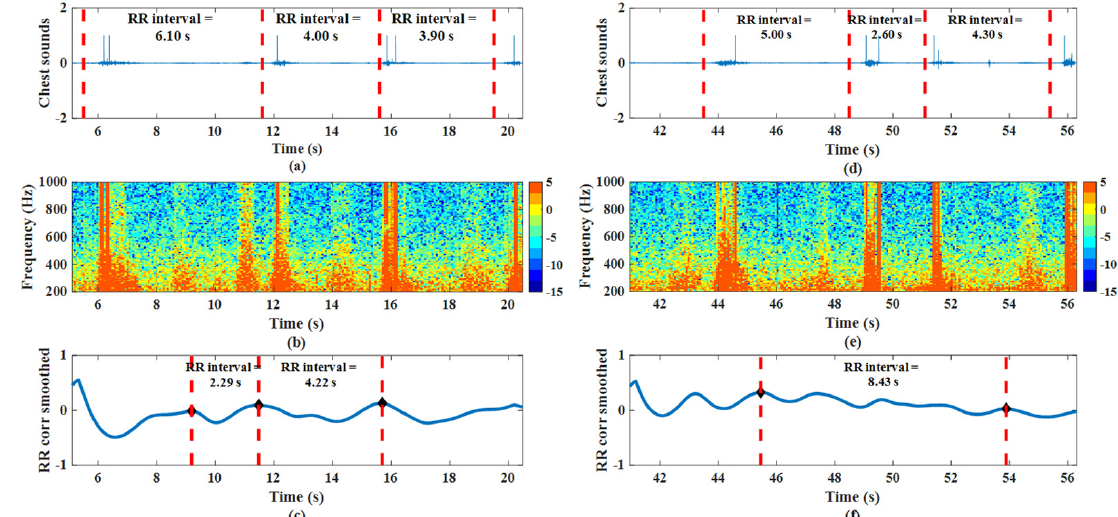
Figure 3. A short segment plot of ( a – c ) participant 10’s recording (estimated RR > actual RR) and ( d – f ) participant 10’s recording (estimated RR < actual RR) in the time-domain between 200 Hz and 1000 Hz, time-domain entropy plot of breath sounds, and autocorrelation plot of entropy signals.